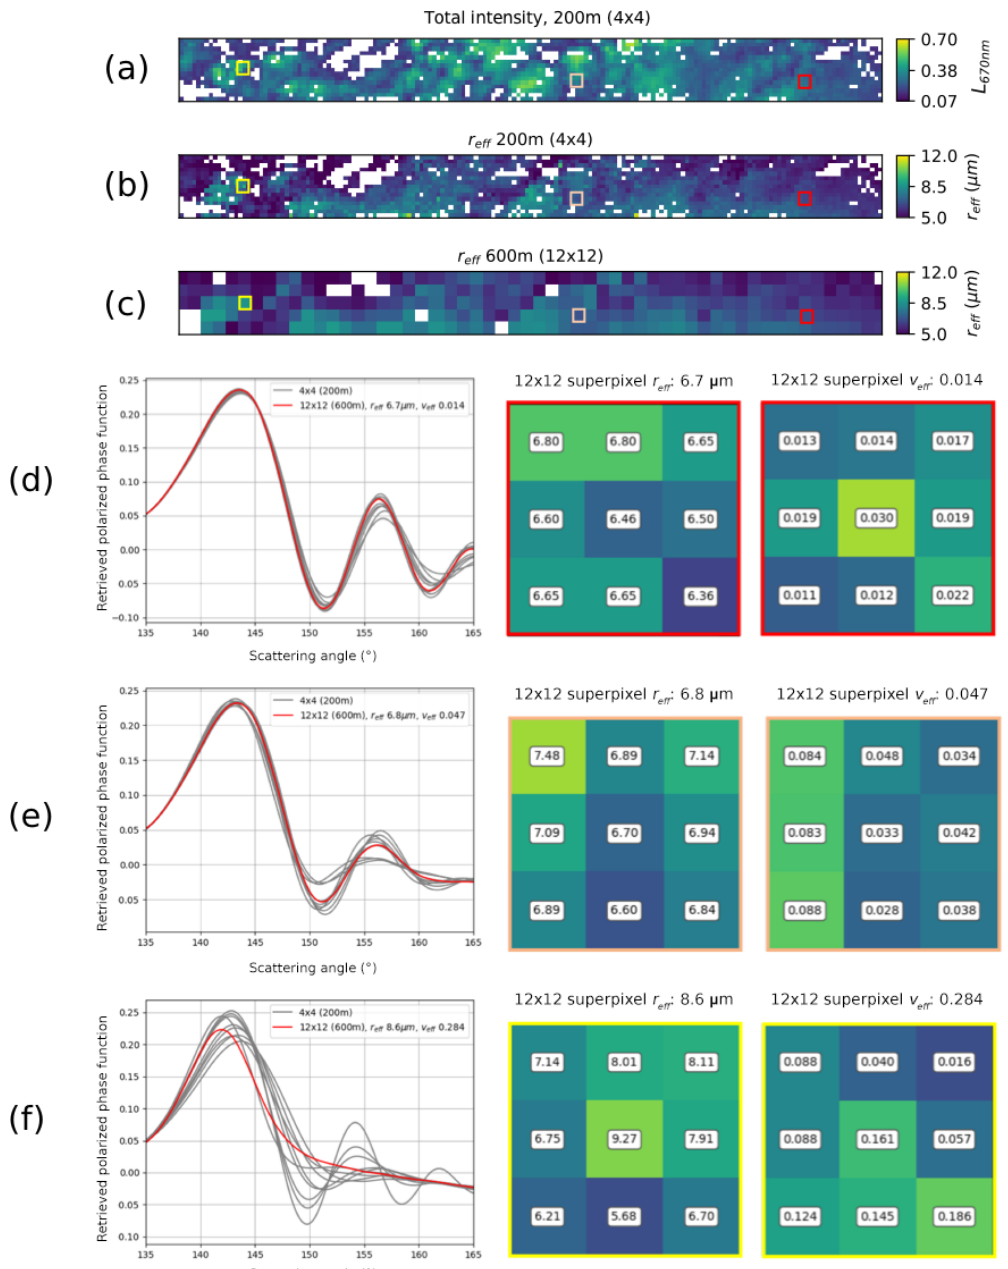
Figure 10. Scale analysis for the scene in Fig. 5 with 200m (b) and 600m (c) resolutions. The Mie P 12 curves retrieved from the AirHARP data are shown with gray lines in panels (d) , (e) , and (f) , and the direct 600m superpixel P 12 retrieval is shown in red for three difference cases: narrow (d) , two-regime (e) , and mixed (f) DSDs. The boxes to the right-hand side show CDR and CDV results for each of the nine 200m pixel retrievals within the outlined 600m superpixel. Results of the direct retrieval at 600m resolution are shown on the top of the boxes. The location of each retrieval site is given as corresponding colored blocks in the retrieval image for narrow (red), two-regime (peach), and mixed (yellow). Note that the 600m retrievals shown in (e) and (f) give wider CDV results than (d) , mainly due to competing size properties at the 200m